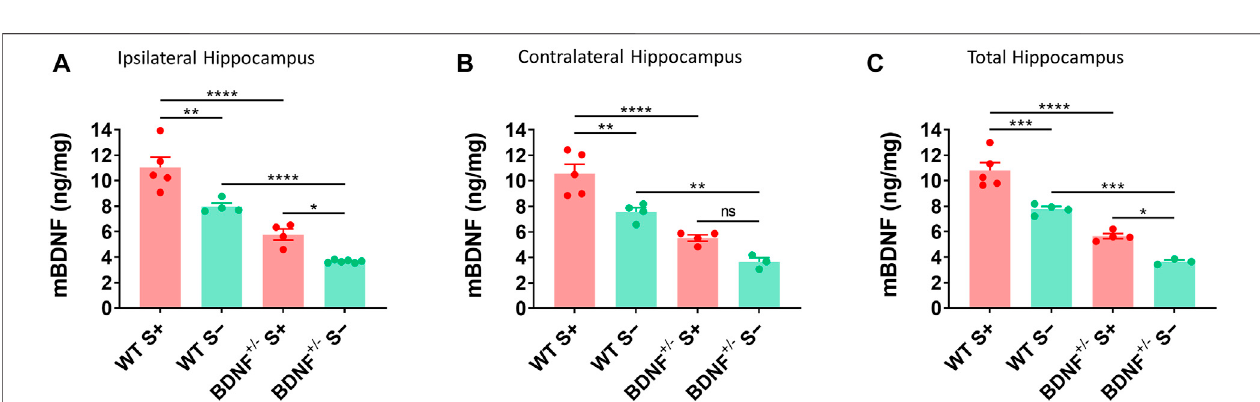
FIGURE6| Increasein mBDNF in hippocampus ofWT compared toBDNF +/ − mice withTMEV-infected acute seizures. (A-C) Absoluteprotein levels ofmBDNF in the ipsilateral (A) , contralateral (B) , and total hippocampus (C) from WT and BDNF +/ − mice at 14 days post-TMEV infection are compared. S+ indicates mice that developed acute TMEV-induced seizures and S- indicates mice that did not get seizures. Statistics: One-way ANOVA, Š ídák ’ s multiple comparisons test; n = 3-6 mice per group at each timepoint; * p < 0.05, ** p < 0.01, *** p < 0.001, **** p < 0.0001.